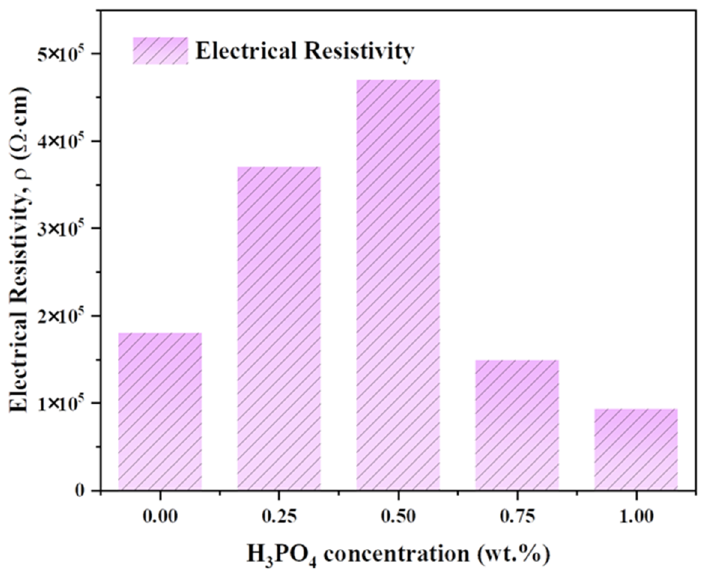
Figure 6. Electrical resistivity for SMCs after coating with different H 3 PO 4